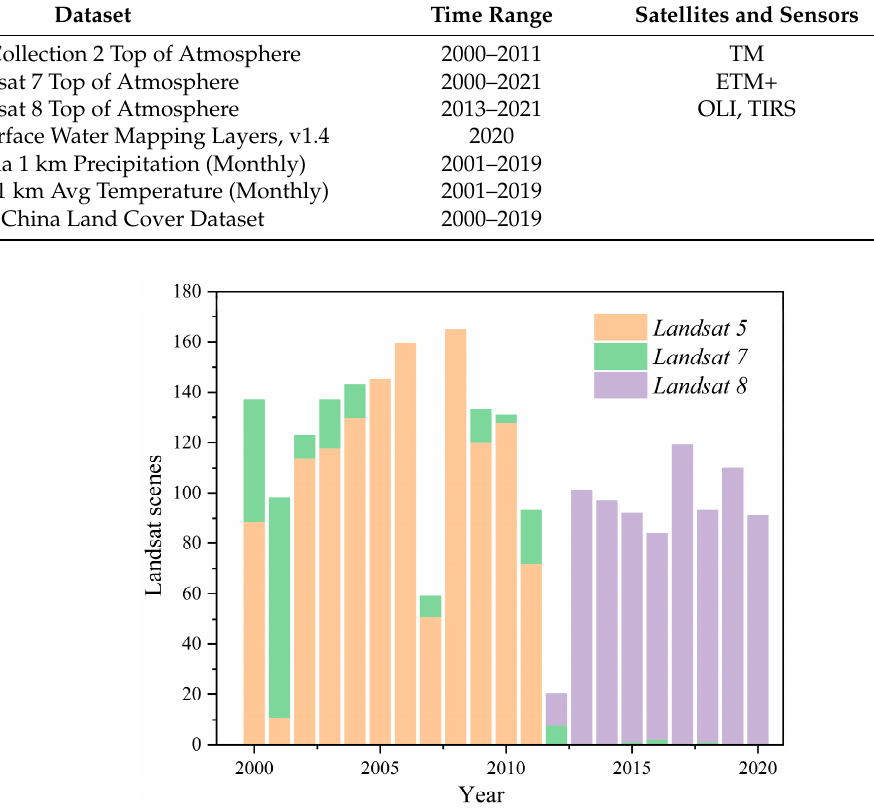
Figure 2. The number of Landsat images used.